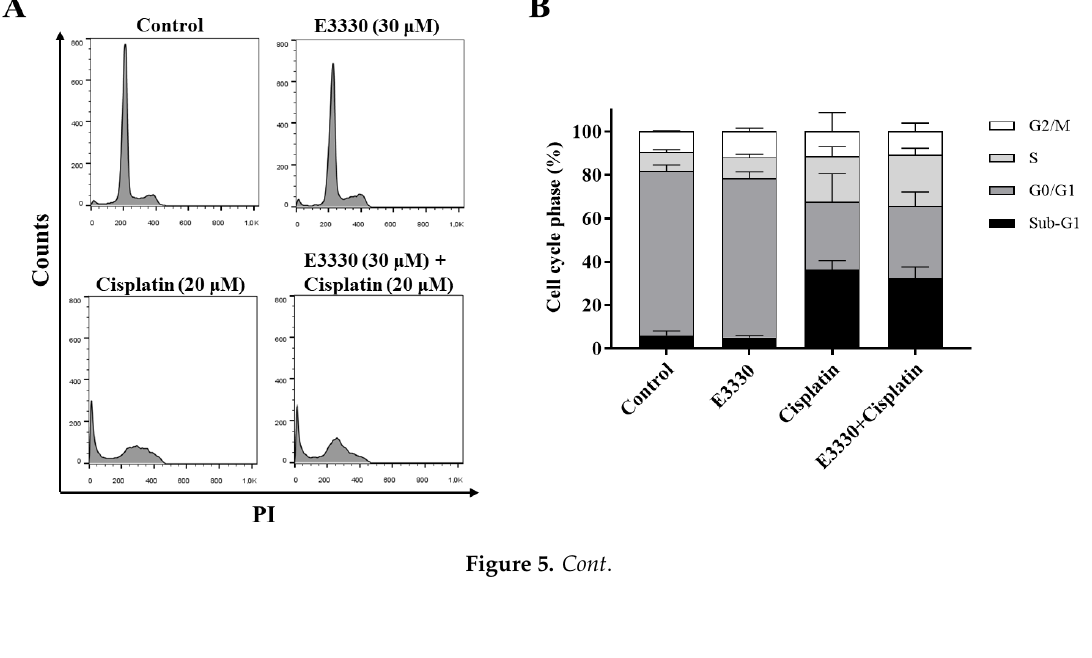
Figure 5. Cell cycle progression and apoptosis of H1975 cells treated with E3330 and/or cisplatin. Cells were pre-incubated with E3330 (30 µM) for 3 h and then cisplatin (20 µM) was added for co-incubation for further 72 h. After this exposure period, cell DNA content analysis with PI staining was performed by flow cytometry. ( A ) Representative flow cytometry histograms. ( B ) Sub-G1, G0/G1, S, and G2/M populations’ summary results. The percentage of apoptotic cells was determined by PI and Annexin V staining after the same incubation profile as in the cell DNA content analysis. ( C ) Representative flow cytometry dot-plots. ( D ) Percentage of viable cells, cells undergoing early and late apoptosis, and necrotic cells summary results. ( E ) Summary results demonstrate the percentage of apoptotic cells (Annexin V positive cells). Values represent mean ± SD ( n = 3), * p < 0.05 (one-way ANOVA with Tukey’s test).